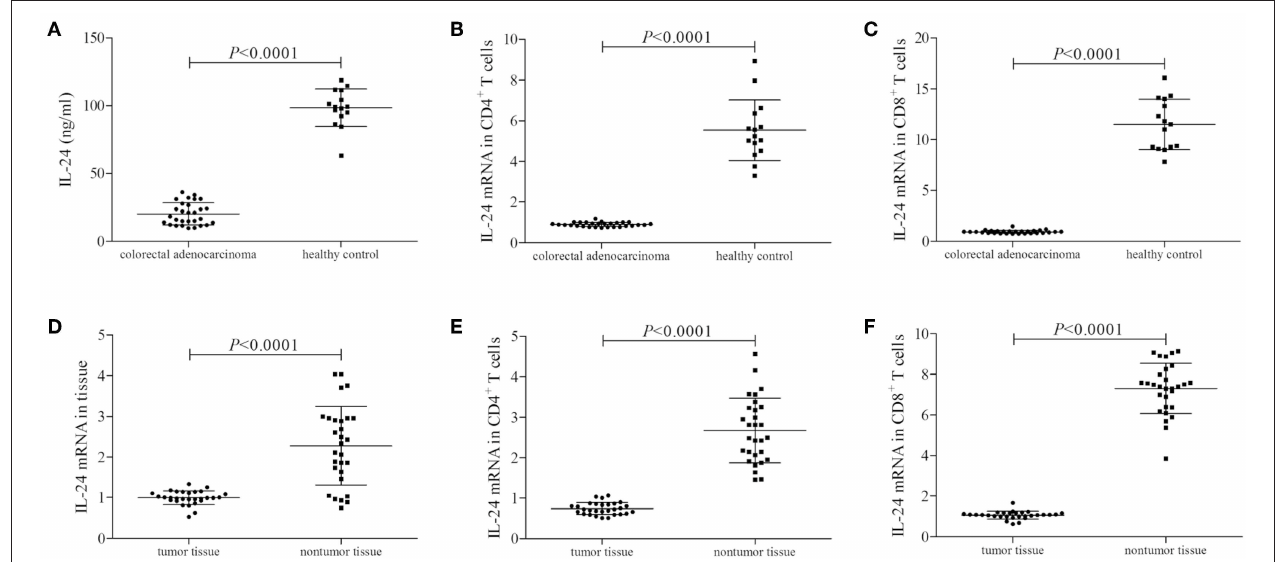
FIGURE 1 | IL-24 expression profile in colorectal adenocarcinoma patients. Plasma IL-24 concentration was measured by ELISA in all enrolled subjects (29 of colorectal adenocarcinoma patients and 15 of healthy controls). IL-24 mRNA relative level was measured by real-time PCR in tumor tissue, peripheral and tumor-infiltrating CD4 + and CD8 + T cells. (A) IL-24 expression in the plasma was reduced in colorectal adenocarcinoma patients. (B) IL-24 mRNA expression was down-regulated in peripheral CD4 + T cells from colorectal adenocarcinoma patients. (C) IL-24 mRNA expression was also down-regulated in peripheral CD8 + T cells from colorectal adenocarcinoma patients. (D) IL-24 mRNA expression was decreased in colorectal adenocarcinoma tissue. (E) IL-24 mRNA expression was down-regulated in tumor-infiltrating CD4 + T cells from colorectal adenocarcinoma tissue. (F) IL-24 mRNA expression was down-regulated in tumor-infiltrating CD8 + T cells from colorectal adenocarcinoma tissue. Individual level of each subject was shown. Student’s t -test, One-way ANOVA, or Mann-Whitney test was used for comparison.